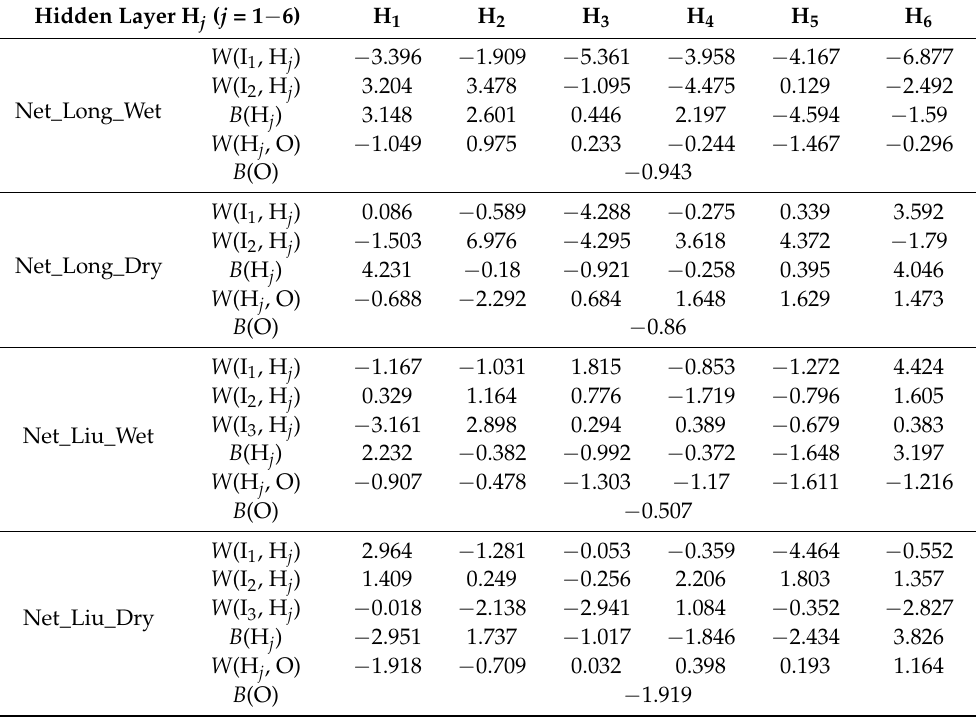
Table 4. Connection weights and thresholds of two-layer FFNNs for ANN rules of Long and Liu reservoirs.